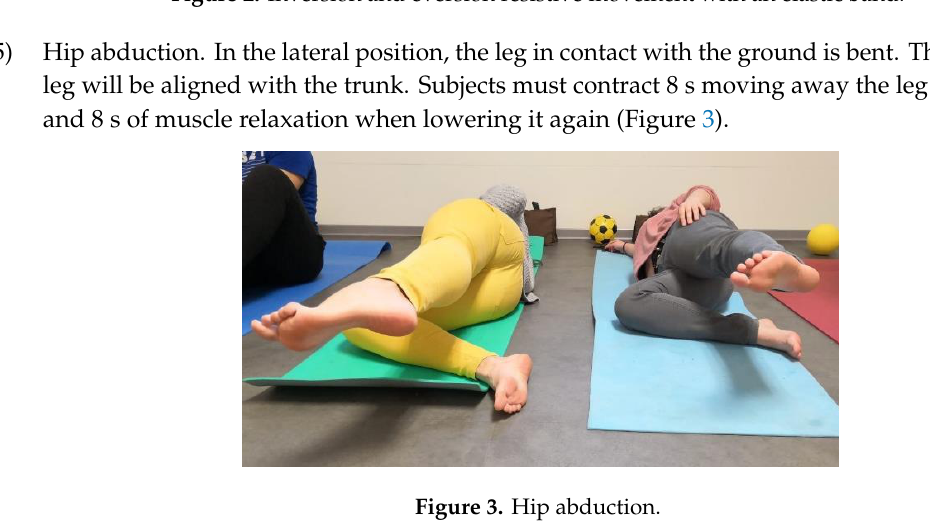
Figure 2. Inversion and eversion resistive movement with an elastic band.